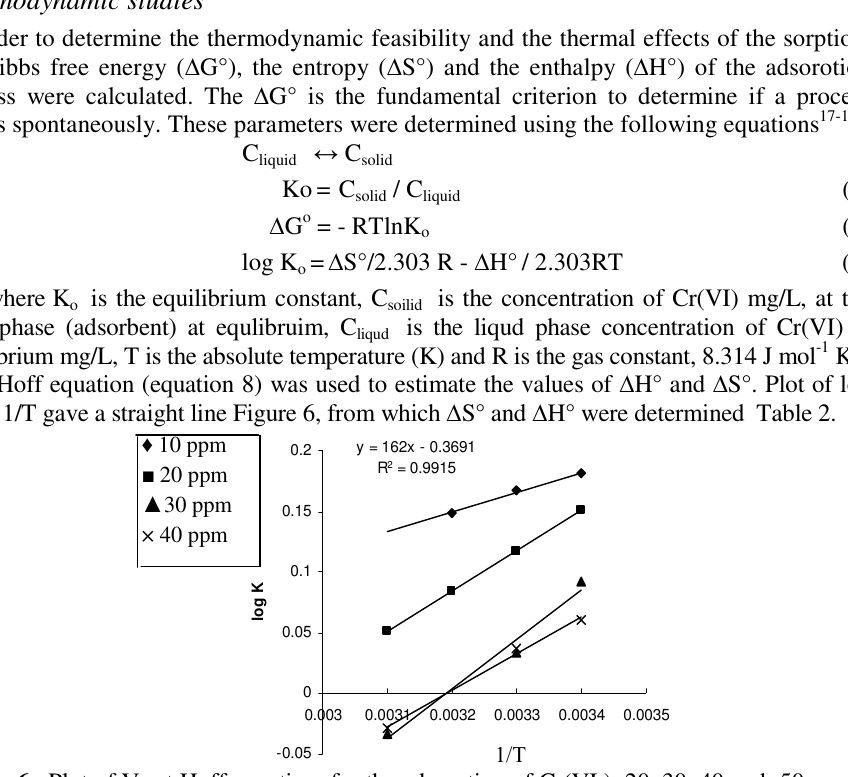
Figure 6. Plot of Van , t Hoff equation for the adsorption of Cr(VI ), 20, 30, 40 and 50 mg /L onto cinnamon 2 g/L.